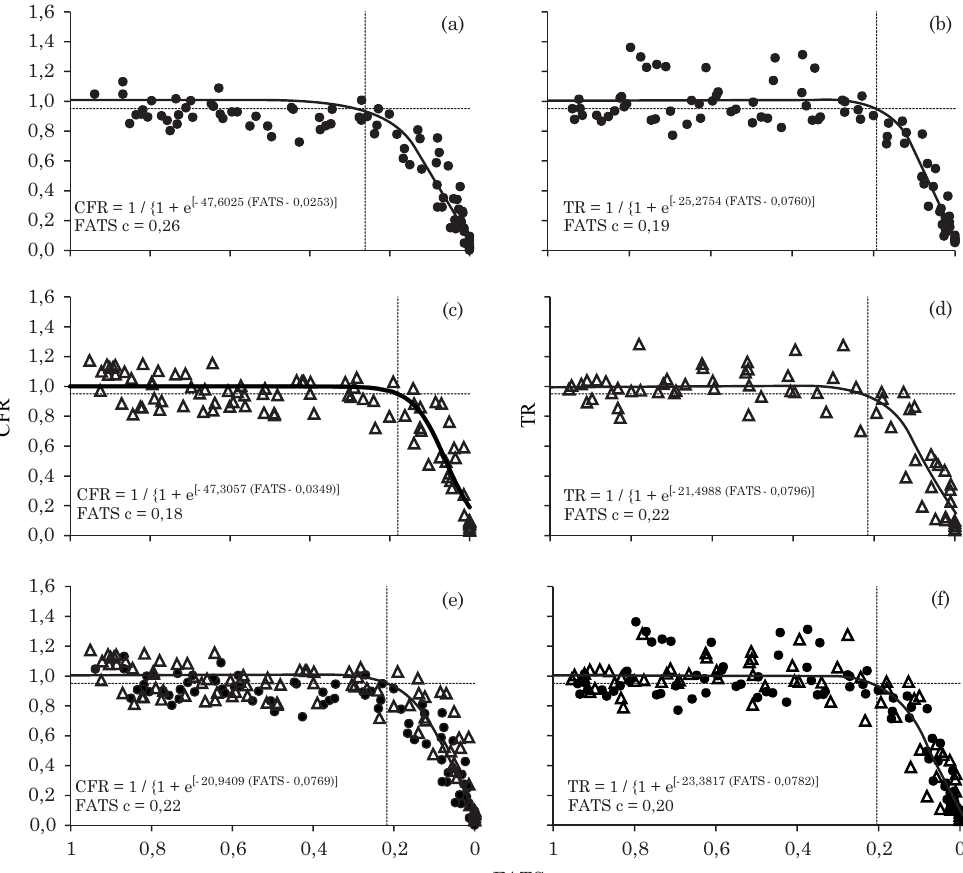
Figura 3. Crescimento foliar relativo (CFR) e transpiração relativa (TR) em função da fração da água transpirável do solo (FATS) em plantas de mandioca, cultivar Fepagro RS 13, somente no segundo período sem irrigação do regime hídrico RH2/RH3 para o experimento 1 (a, b), para o experimento 2 (c, d) e para a análise conjunta dos dois experimentos (e, f), iniciados em 29/09/2011 (círculo) e em 24/11/ 2011